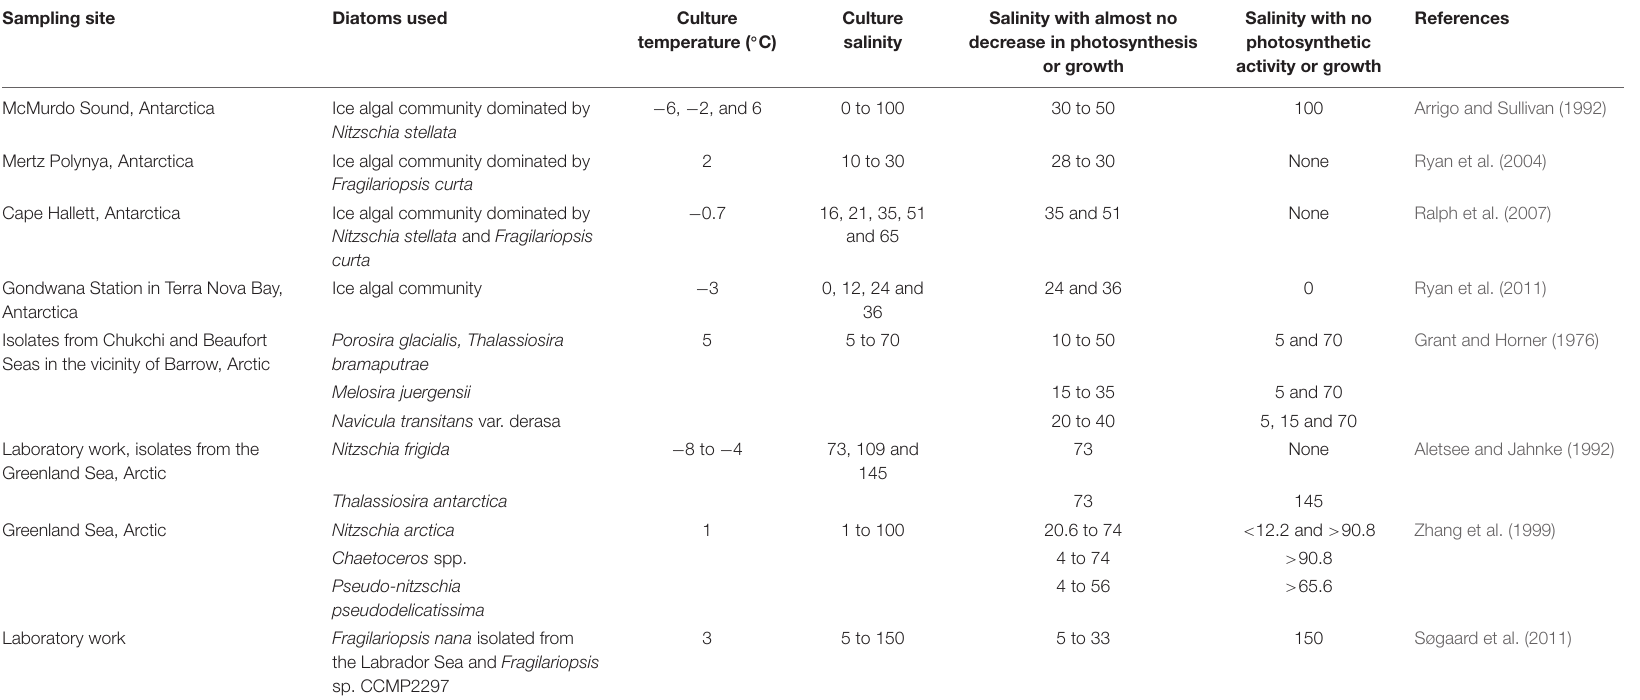
TABLE 1 | A summary of the effect of salinity on photosynthesis and growth of ice algae in previous studies. Sampling